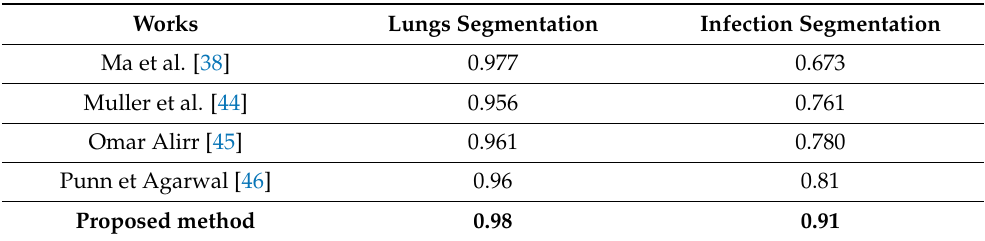
Table 6. Quantitative comparison of COVID-19 CT lung and infection segmentation results in terms of Dice Coefficient.